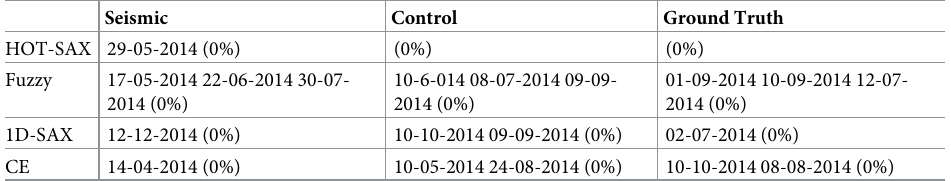
Table 4. Swarm A Grid 5, Ludian experimental results.